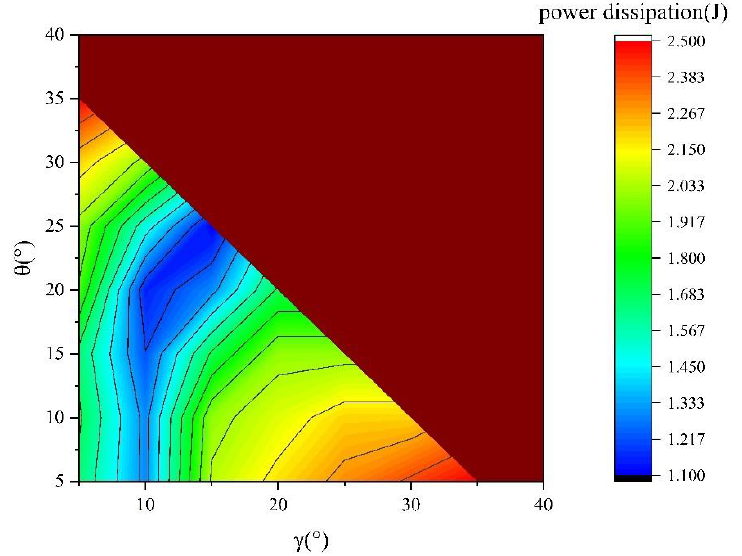
Figure 12. Distribution law of frictional energy dissipation (Q) of contact pin under different combinations of angles γ and θ .